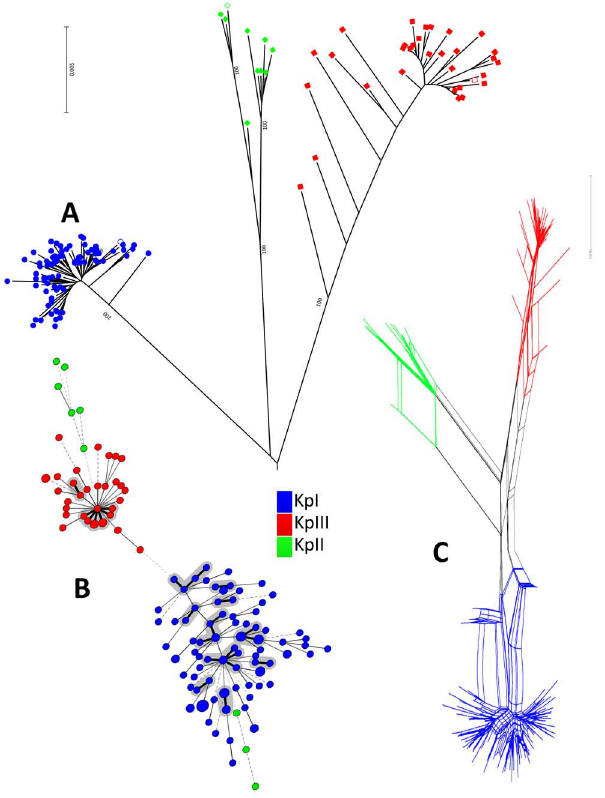
Figure 1. Phylogenetic representation of all isolates. A : Radial phylogenetic tree of 139 isolates based on the concatenated sequences of seven MLST loci performed using the Neighbor-joining method based on a Jukes-Cantor distance matrix. Main bootstrap values obtained are highlighted on at the main node of the phylogeny. The tree was rooted using the nucleotide sequences of the seven genes of E. coli and considered as an out-group. Each phylogroup was clearly separated from others. Colors of isolates symbols are specific of each phylogroups. Blue color corresponds to the KpI phylogroup, green corresponds to KpII, and red corresponds to KpIII. Empty symbols correspond to the references strains specific for each phylogroups. B : Minimal Spanning Tree (MST) analysis of Klebsiella pneumoniae strains based on MLSTallelic profiles. Each circle corresponds to an ST. The area of each circle corresponds to the number of isolates. The relationships between strains are indicated by the connections between the isolates and the lengths of the branches linking them. Black lines connecting pairs of STs indicate that they differ in one allele (thick lines), two and three alleles (thin), or four to seven alleles (dashed). Colors of isolates symbols are specific to each phylogroup: blue - KpI, green - KpII and red - KpIII. Grey zones surround STs differing in one allele forming a clonal complex. C : NeighborNet graph based on seven concatenated housekeeping genes, illustrating the recombination within and among phylogroups. Colors surrounding each zone are specific of each phylogroup. Blue color corresponds to the KpI phylogroup, green corresponds to KpII, and red corresponds to KpIII.